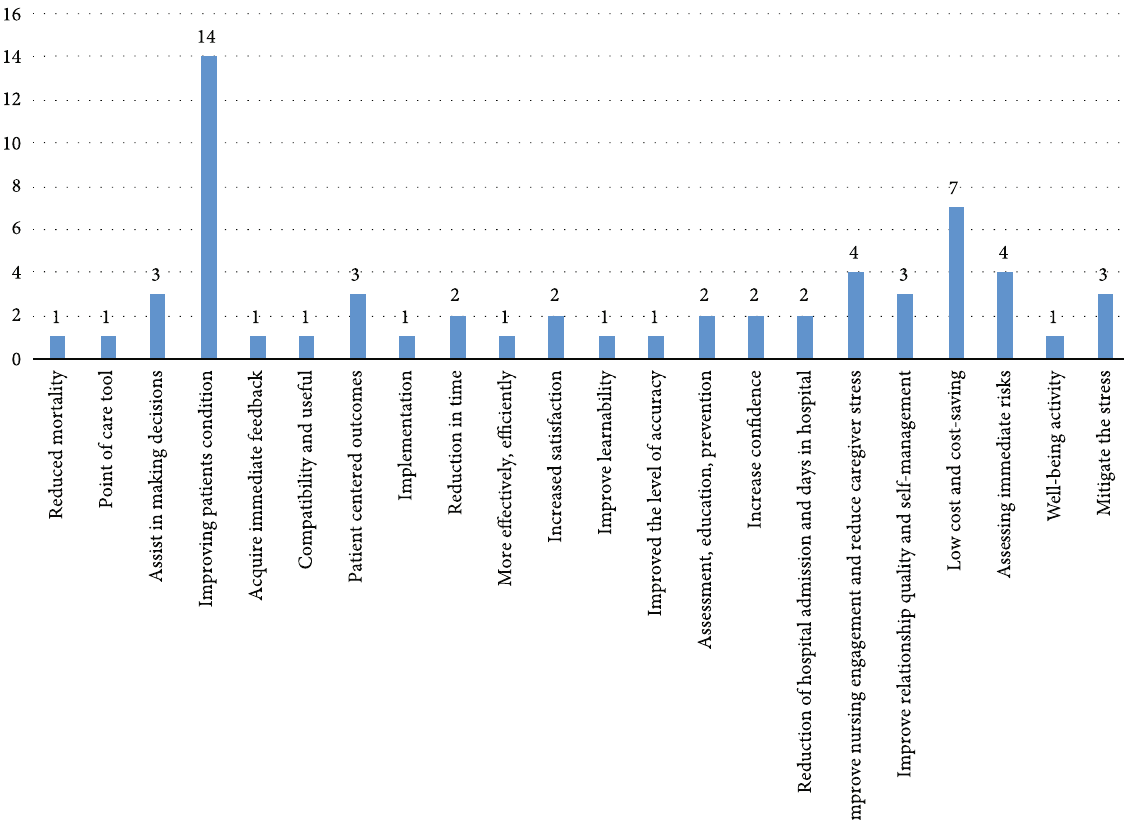
Figure 4: Frequency of addressed bene fi ts of applying personalized mobile apps for elderly